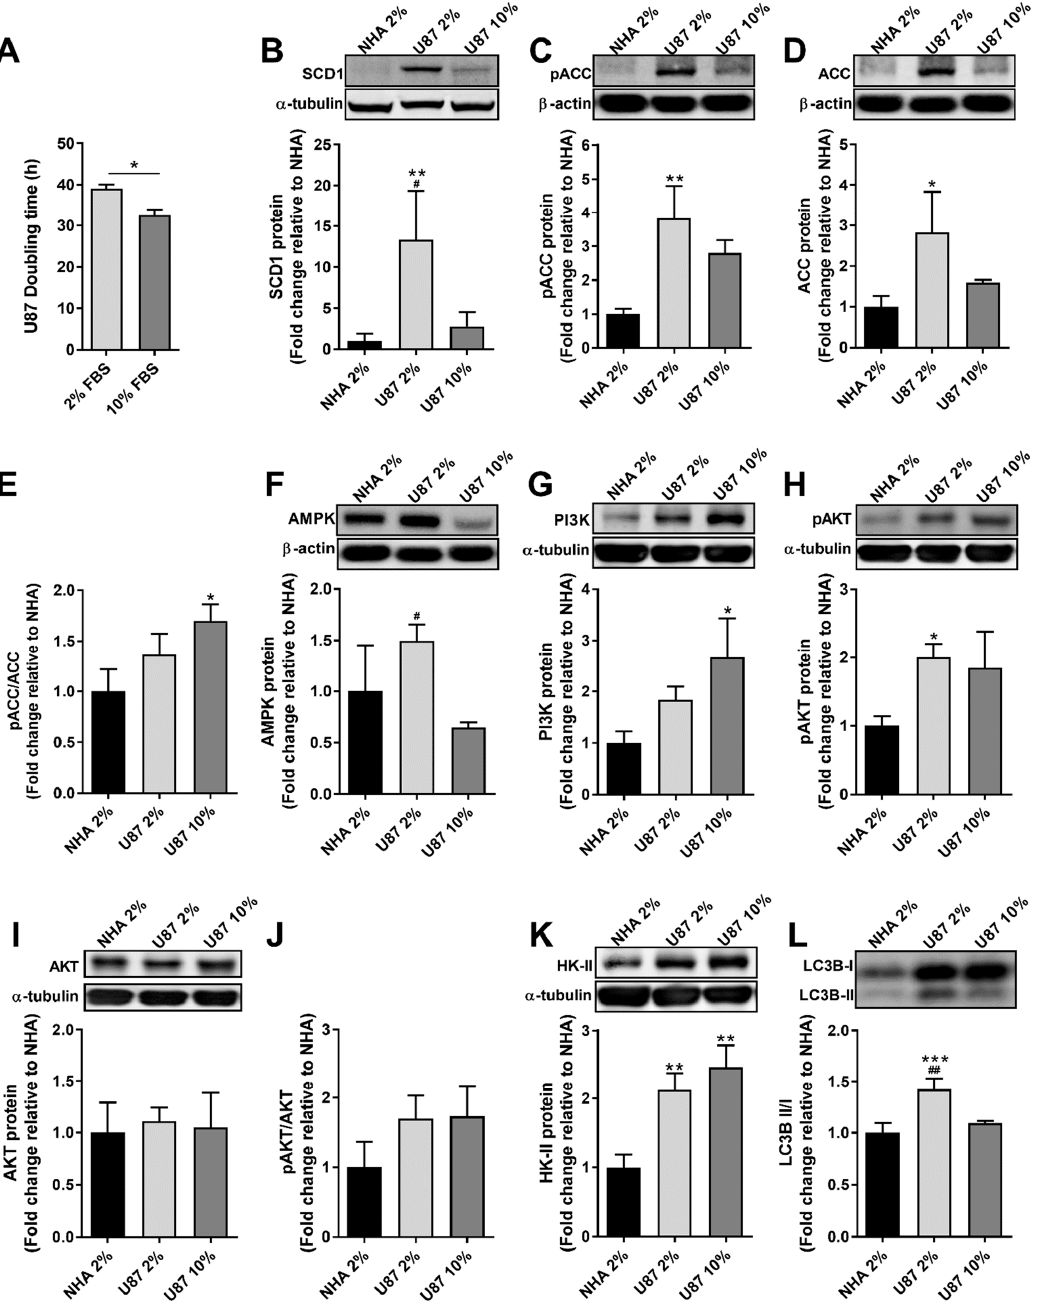
Figure 1. Effect of growth medium serum content on U87 cell proliferation and expression of pro- teins involved in cell metabolism and autophagy. Cells were plated in growth medium containing serum at a standard (10% FBS) or reduced concentration (2% FBS), and cell-doubling times were determined using the SRB assay ( A ); n = 2; unpaired two-sided t -test; * p < 0.05). The levels of SCD1 ( B ), pACC (C), ACC ( D ), pACC/ACC ( E ), AMPK ( F ), PI3K ( G ), pAKT ( H ), AKT ( I ), pAKT/AKT ( J ), HK-II ( K ) and LC3B II/I ( L ) were evaluated by Western blot analysis in normal human astrocytes